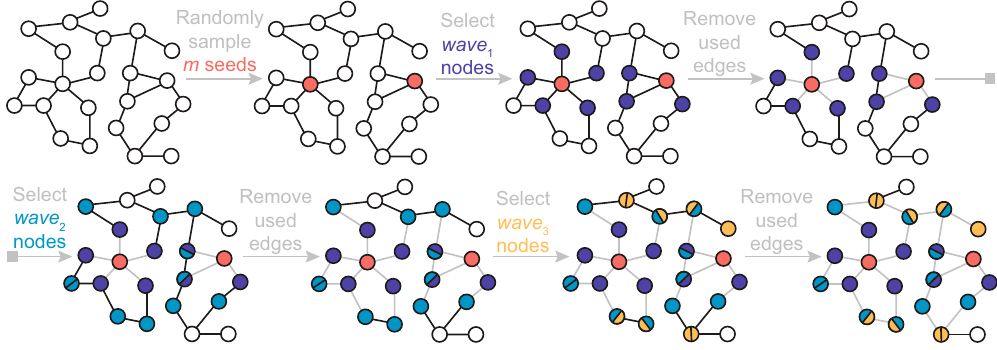
Figure 1. Steps of the LSMI algorithm with m = 2 seeds and d = 3 waves applied to a network of order n =